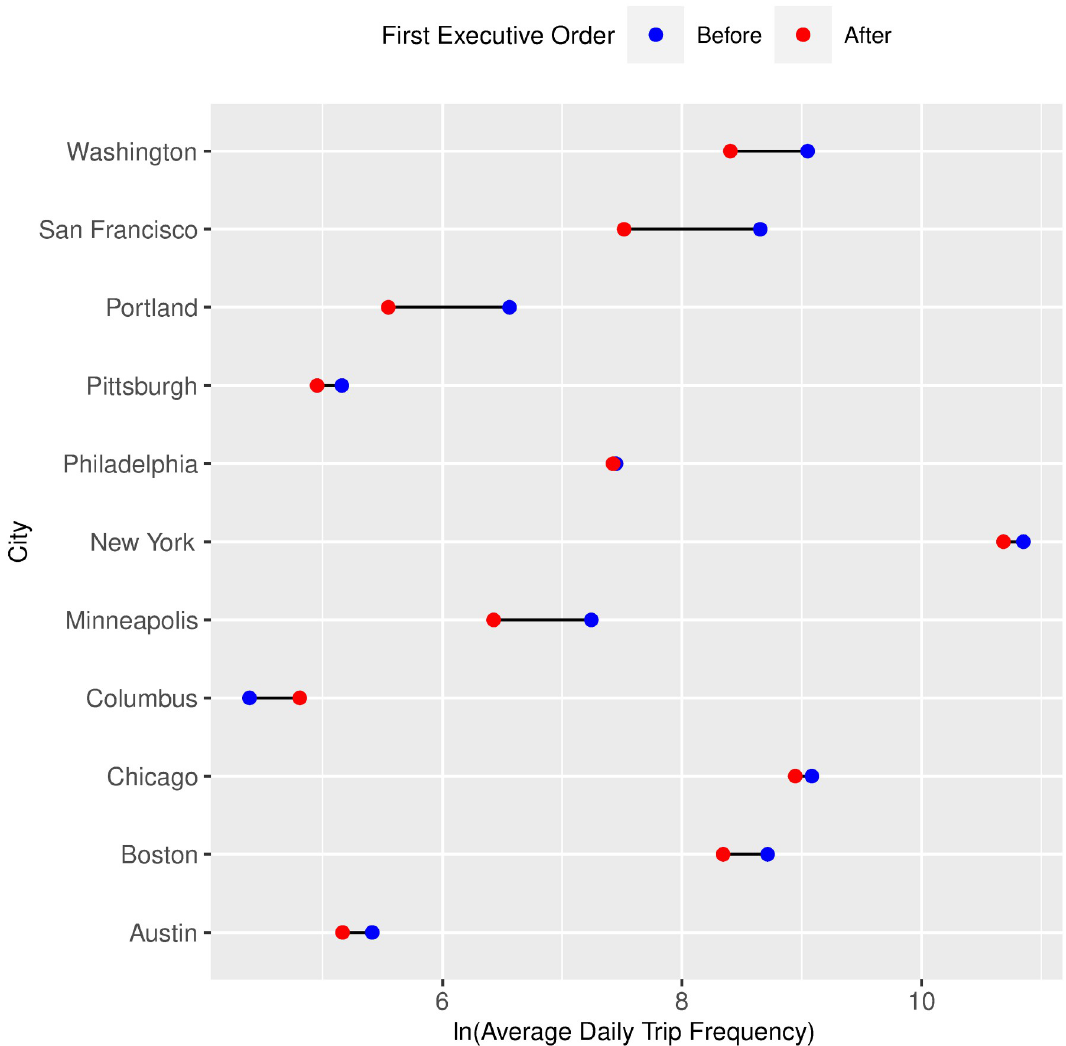
Fig 4. Dumbbell chart comparing the average daily bike-sharing trip frequency before and after the first executive order implementation.